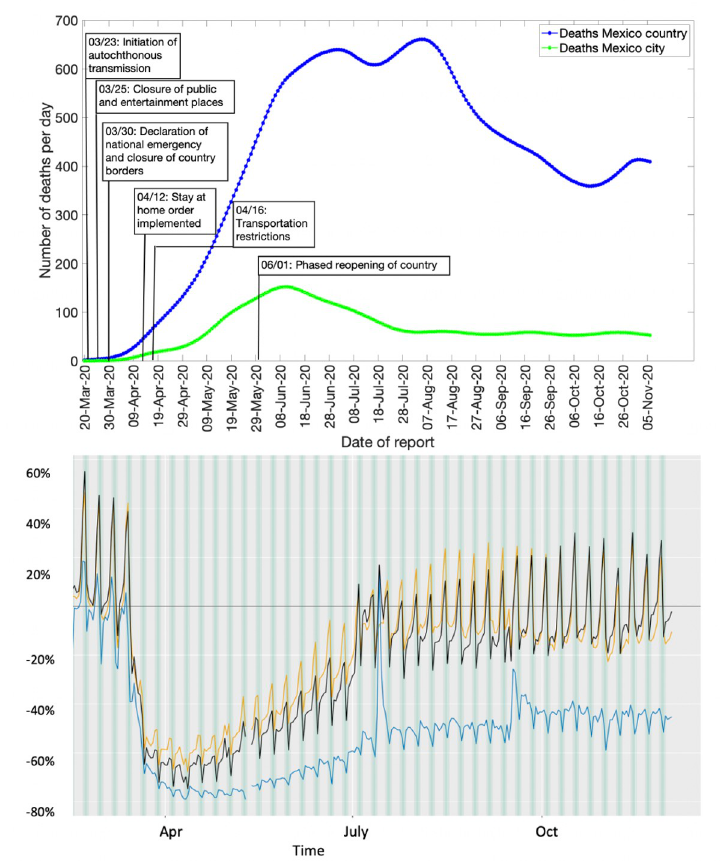
Fig 1. Upper panel: Epidemic curve for the COVID-19 deaths in Mexico and Mexico City from March 20-November 11, 2020. The blue line depicts the confirmed deaths in Mexico and the green line depicts the confirmed deaths in Mexico City. Lower panel: The mobility trends for Mexico from February 28-December 5, 2020. The orange line shows the driving trend, the blue line shows the transit trend, and the black line shows the walking trend.